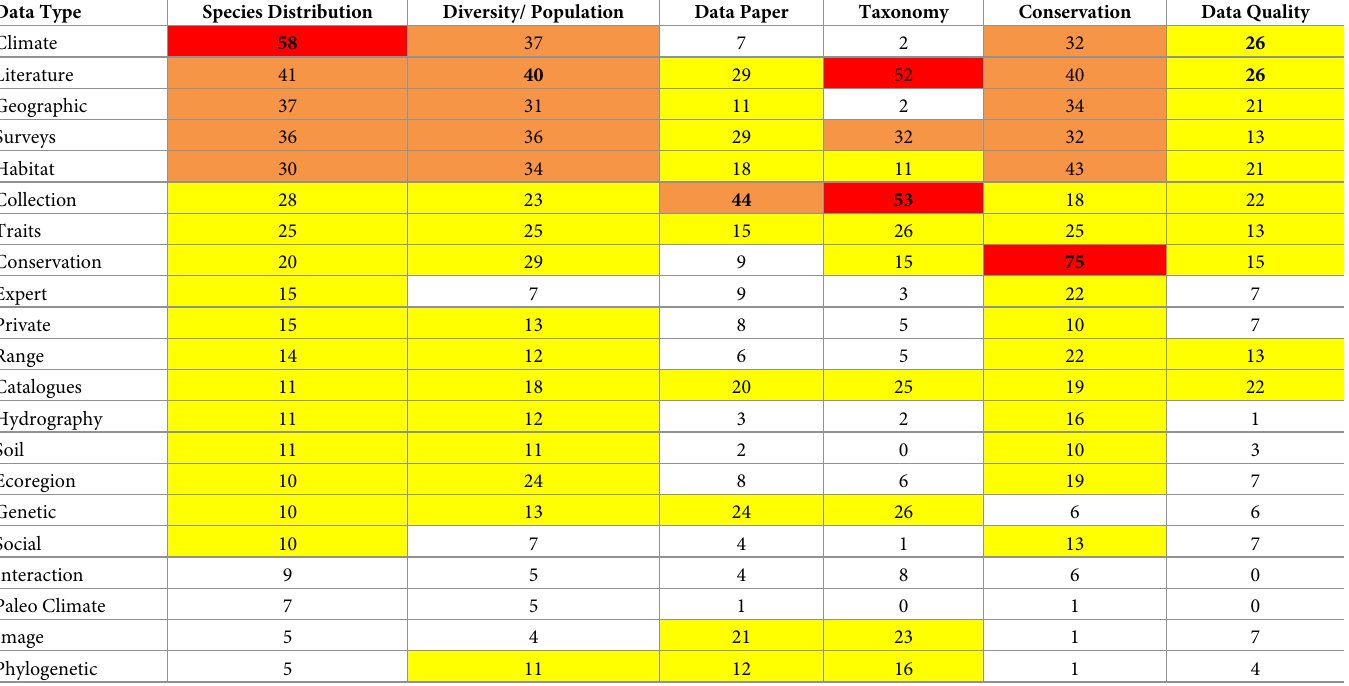
Table 5. Percentage of papers that associate online occurrence data with other data types—Separated by the six top uses of these databases. Nine data types with the lowest percentages were removed from table. The top data type for each research use is bolded, and percentage values above 10% are highlighted yellow (10–29%), orange (30–49%), and red ( >